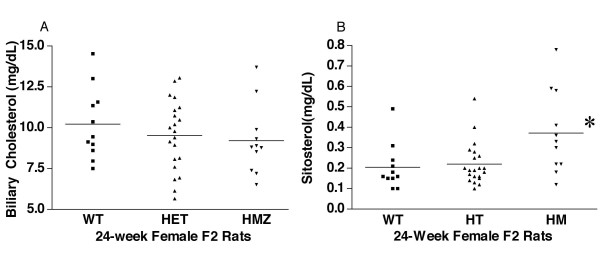
Biliary cholesterol and sitosterol concentrations. Female F2 rats, on a defined sitosterol diet (see text) had their bile ducts cannulated and bile collected under gravity and analyzed for cholesterol (panel A) or sitosterol (panel B). No differences in the cholesterol content of bile were noted between any of the genotypes. Note that the concentration of cholesterol is approximately 50-fold more than sitosterol. Interestingly, the sitosterol concentration in the F2 HMZ rats was increased significantly by ~ 50% relative to WT and HET rats (panel B).